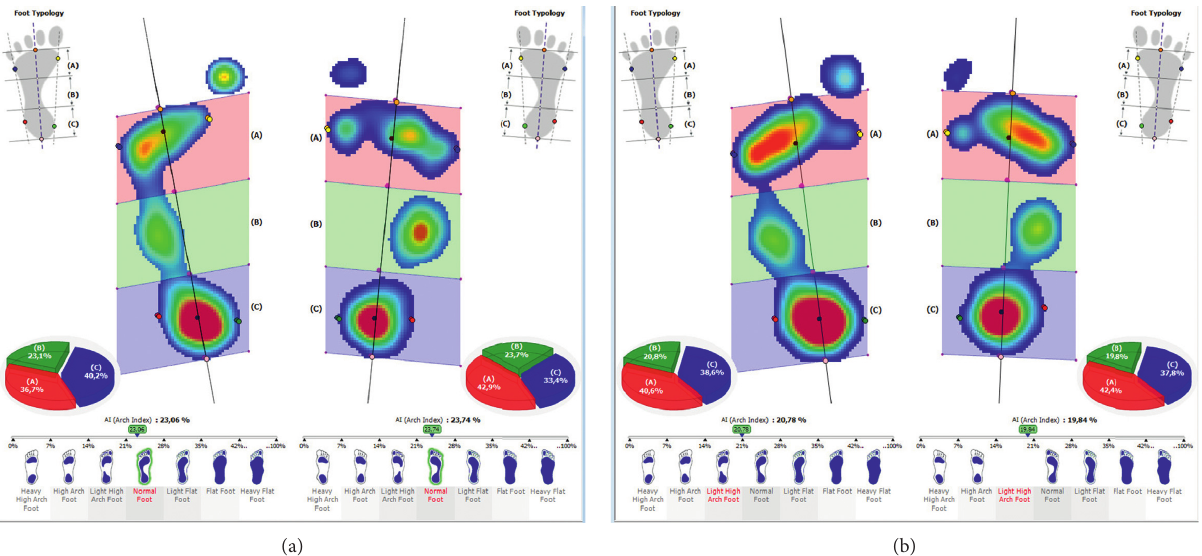
Figure 9: The exemplary result of the foot arch examination (a) before and (b) after a therapeutic session (the examination is performed while